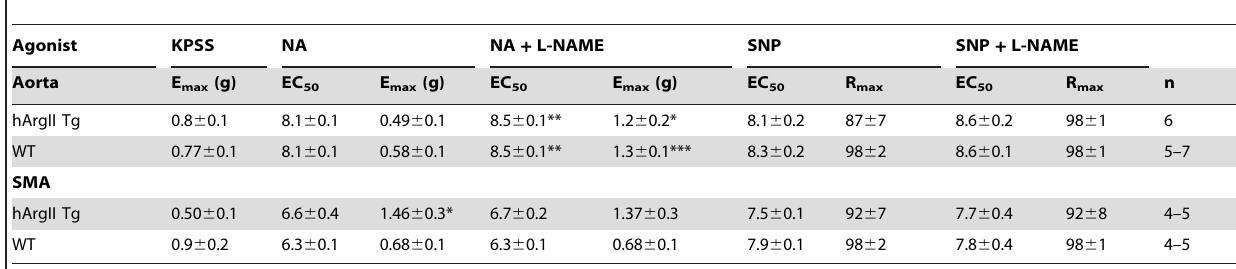
Table 2. Responses to noradrenaline (NA) and sodium nitroprusside (SNP) in the absence and presence of the NOS inhibitor L- NAME (100 m M) in aorta and small mesenteric arteries from male homozygous Line 11 hArgII mice and their male WT littermate